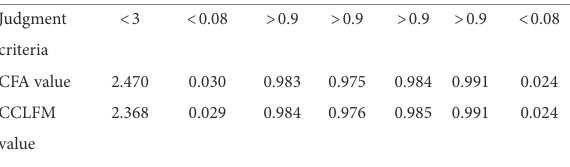
TABLE 4 Model fitting index comparison results of confirmatory factor analysis (CFA) and calculating the common latent factor method